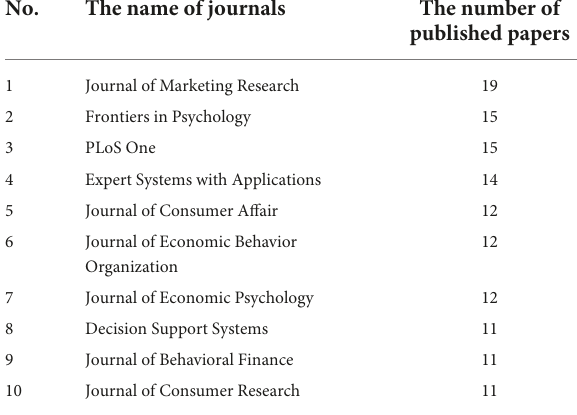
TABLE 1 Top ten most fruitful